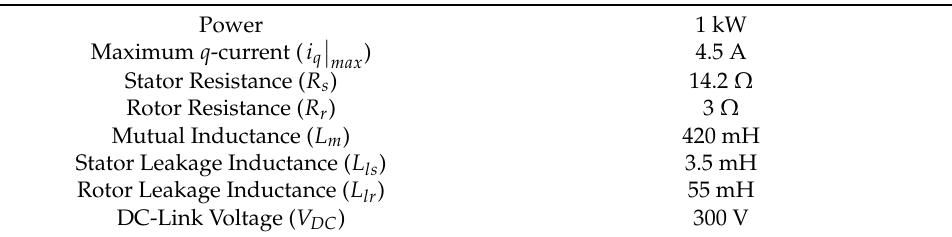
Figure 6. Test bench. Table 1. Summary IM parameters.